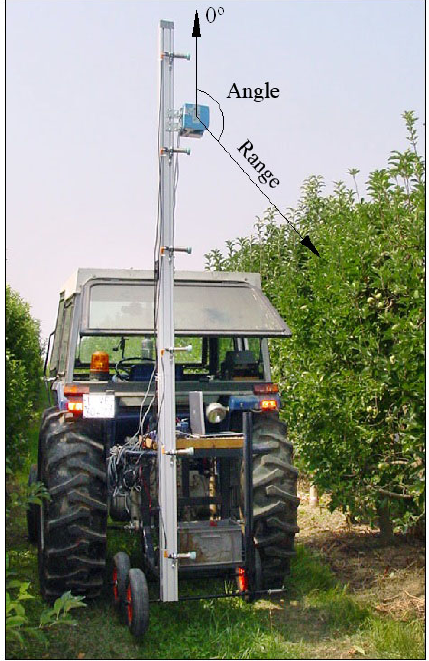
Figure 1. The impact points of the0 laser beam are determined by polar coordinates: range and